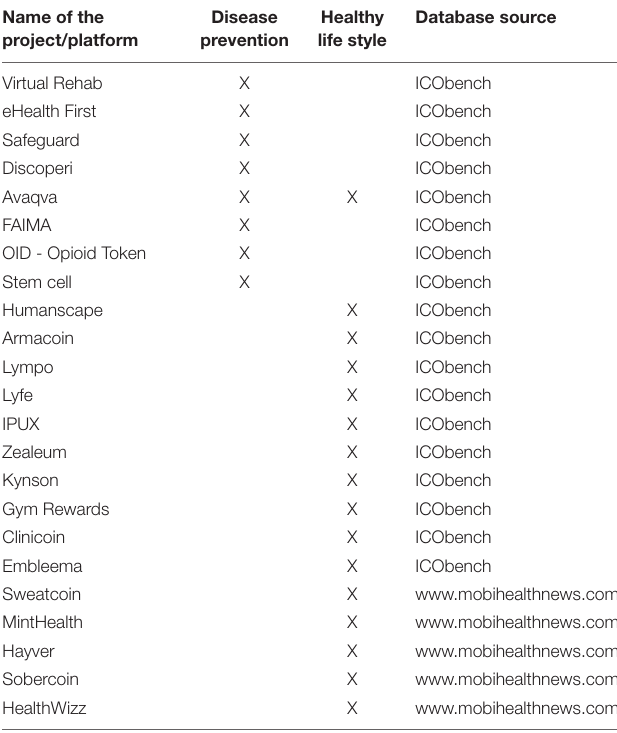
TABLE 2 | List of the projects based on blockchain technology related to prevention of diseases and/or promoting healthy life style. Name of the Disease project/platform